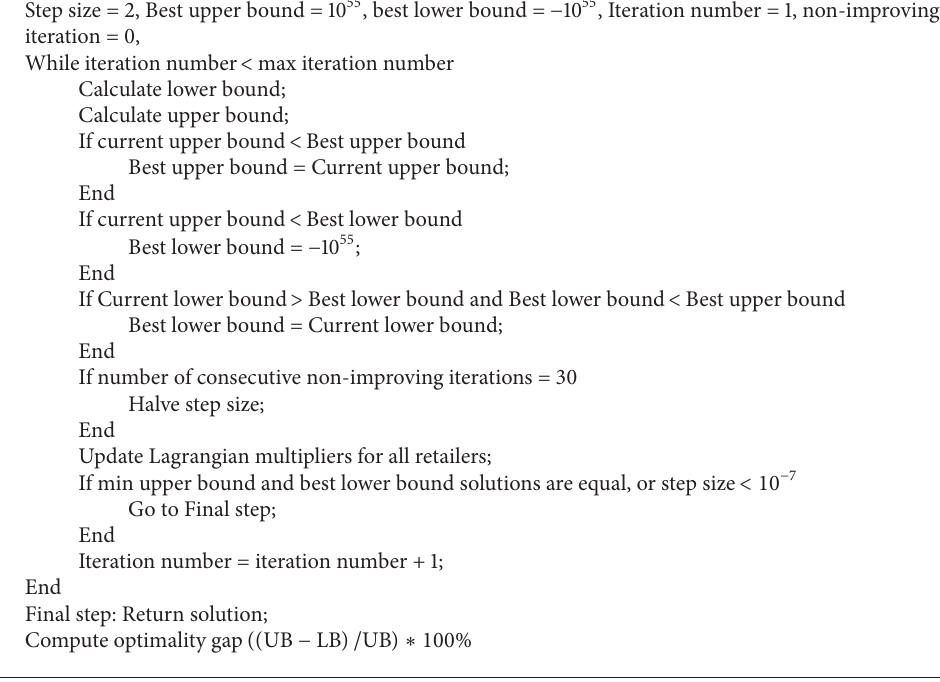
Algorithm 3: Lagrangian relaxation heuristic